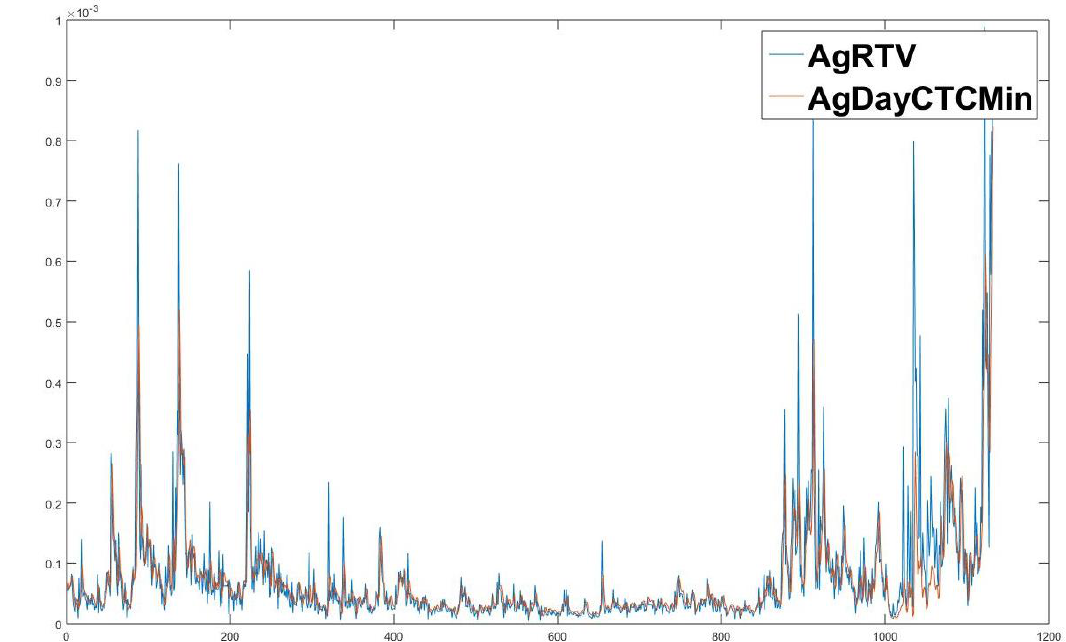
Figure 1. Model CTCM-RTV-D Estimation for Ag(SHFE). The horizontal line is the timeline, and the perpendicular line is the volatility estimator. The actual values are represented by the blue line, while the estimated values are represented by the orange line. During the Day 400 and the Day 800, when the volatility is smooth, the estimated values are almost consistent with the actual values. The CTCM-RTV-D model also captures the characteristics of the volatility when it is volatile.